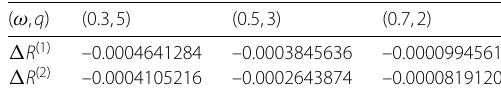
Table 1 Values of risk difference for p =